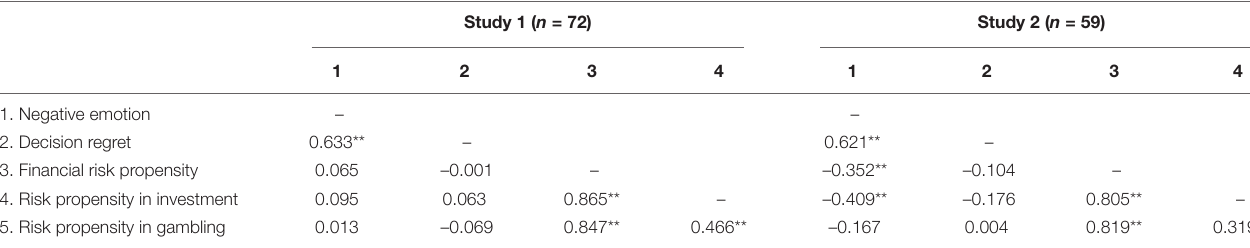
TABLE 1 | Correlation analysis of key measured variables in Studies 1 and 2.